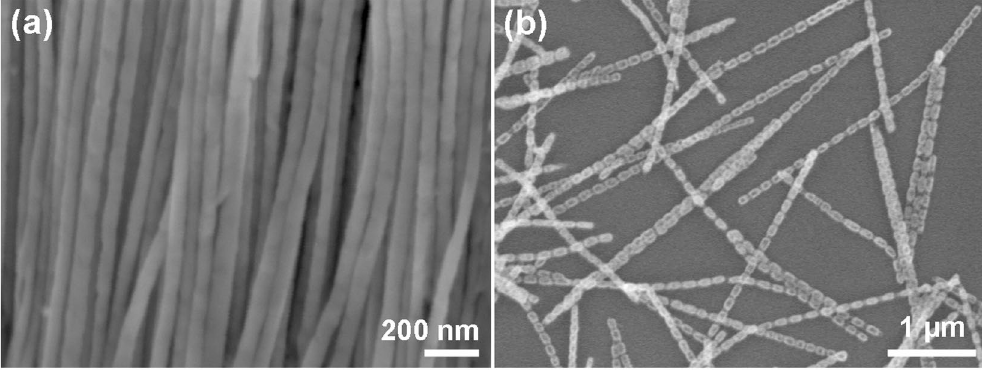
Figure 1. Morphology before and after annealing. FE-SEM images of ( a ) Ni/Cu nanowires arrays released from the AAO template and ( b ) after annealing at 700 °C for 2 h in